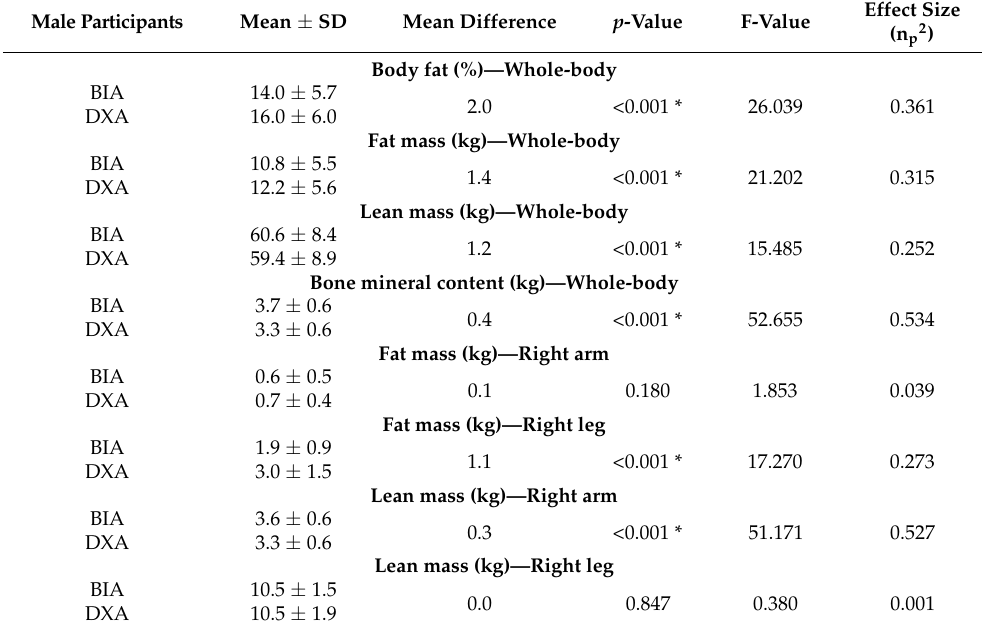
Table 2. Descriptive statistics (mean ± standard deviation) and one-way repeated measures ANOVA test results comparing BIA and DXA for body fat percentage, fat mass, lean mass and bone mineral content at the whole-body and/or segmental level on the right-hand side of the body for men ( n = 47). Male Participants